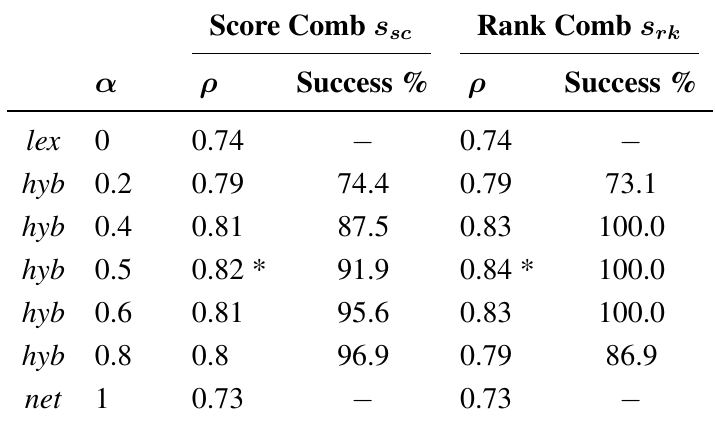
Table 6. Cognitive plausibility of NLS. Max ρ is the upper bound obtained by an approach. net : network measure; lex : lexical measure; hyb : hybrid measure. * Best performance. For all Spearman’s tests, p < 0 . 001